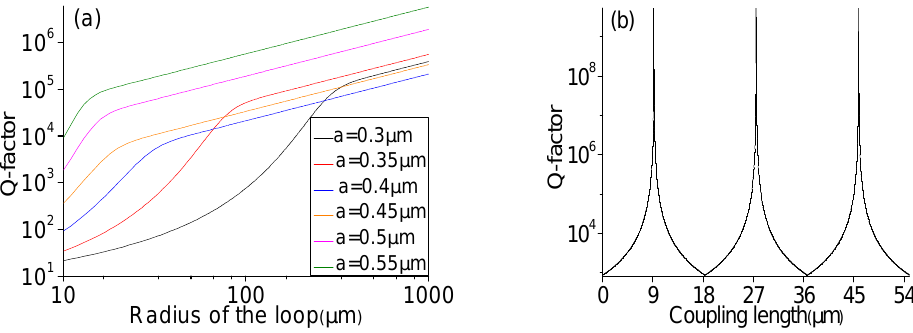
Figure 3. (a) Q -factor versus the radius of the loop R and the radius of the microfiber a , fixed parameter ∆ l =10 µ m (b) Q -factor versus the coupling length ∆ l , fixed parameters a =0.5 µ m, R =55 µ m.